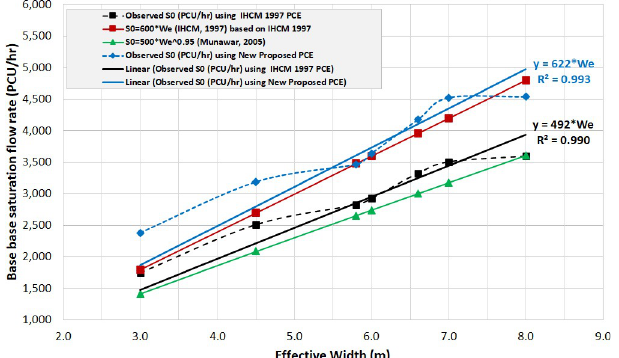
Fig 6. Comparing plot among base saturation flow rate model prediction using IHCM PCEs and new proposed PCEs.